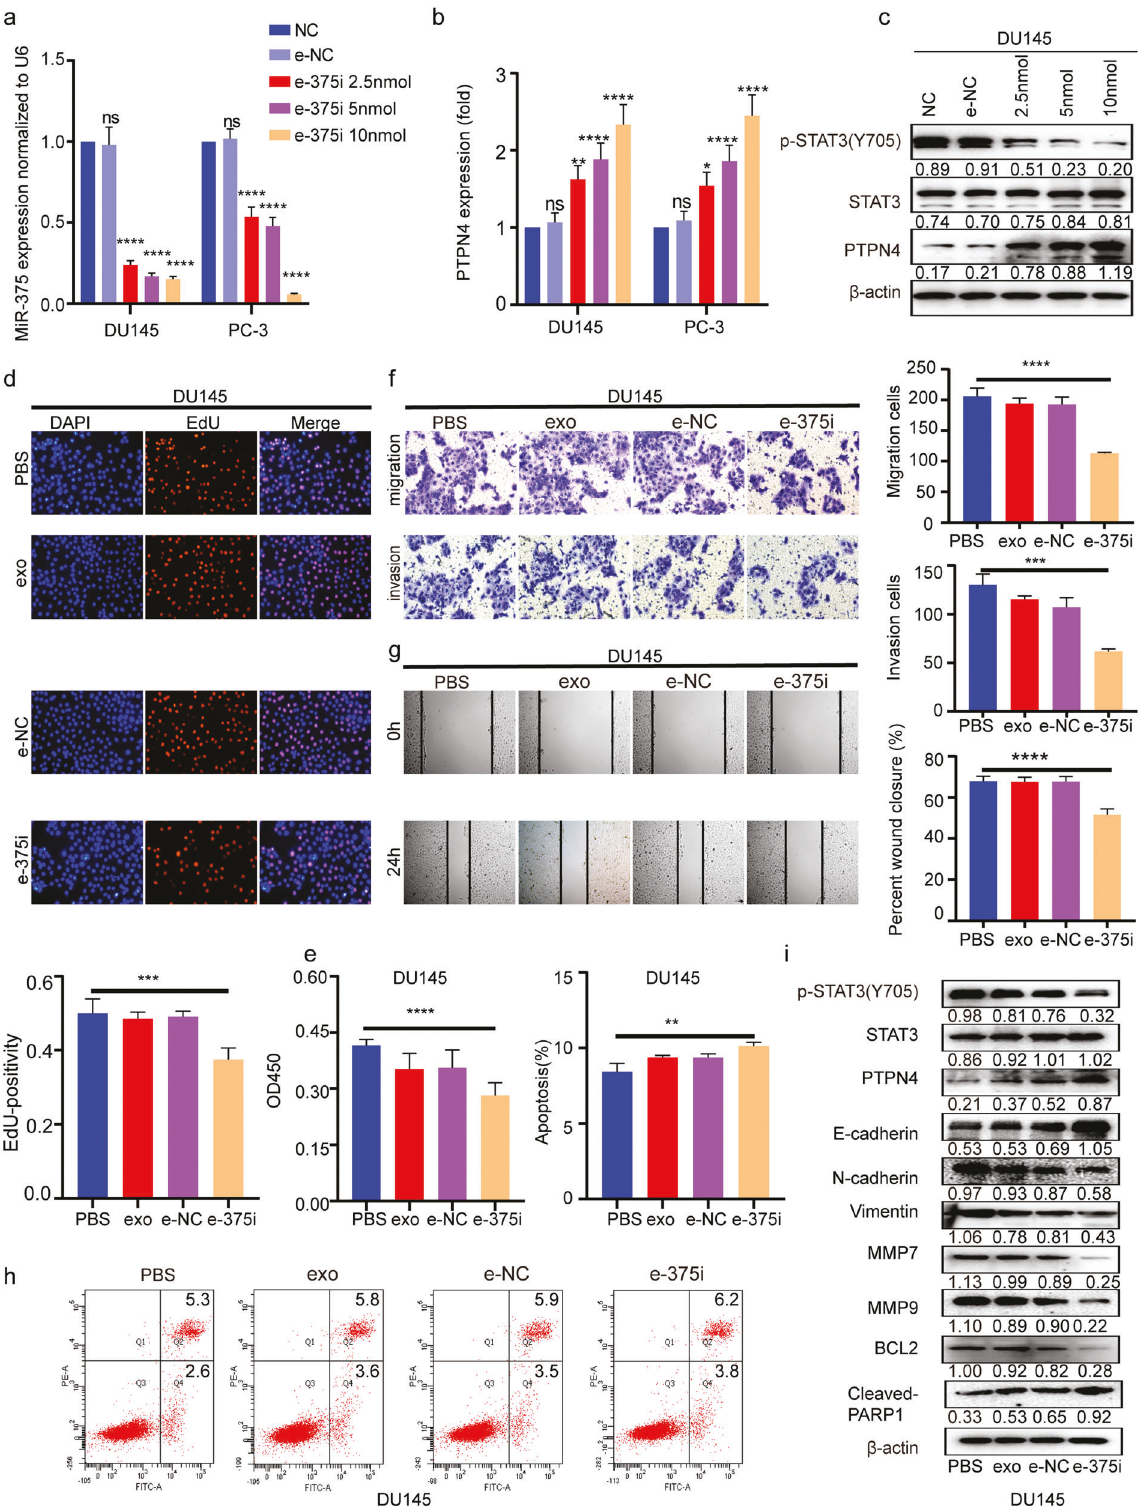
Fig. 6 E-375i inhibited PCa proliferation, migration, and invasion while promoting apoptosis in DU145 cells. qRT-PCR illustrating miR-375 AMO loaded and intercellular transferred by hucMSC derived exosomes inhibited expression of miR-375 in DU145 and PC-3 cells ( a ), diminished the inhibitory effect on PTPN4 ( b ) in a dose-dependent manner determined by qRT-PCR, as well as downregulated the protein expression of p-STAT3 and upregulated PTPN4 ( c ) in a dose-dependent manner in DU145 cells, which were determined by western blot. d EdU incorporation and e CCK-8 assays were used to assess the role of miR-375 AMO-loaded exosomes on the proliferation of DU145 cells. f Transwell and g wound- healing assays were applied to test the effects of miR-375 AMO on cell migration and invasion in DU145 cells. h Flow cytometry was conducted to test the function of miR-375 AMO on the apoptotic rate of DU145 cells. i The effect of miR-375 AMO on the protein expression of p-STAT3, EMT and apoptosis markers in DU145 cells. PBS: cells treated with PBS that served as suspension control of exosomes. NC: scramble oligonucleotide. exo: exosomes suspended in PBS. e-NC: exosomes loaded with scramble oligonucleotides. e-375i: exosomes loaded with miR-375